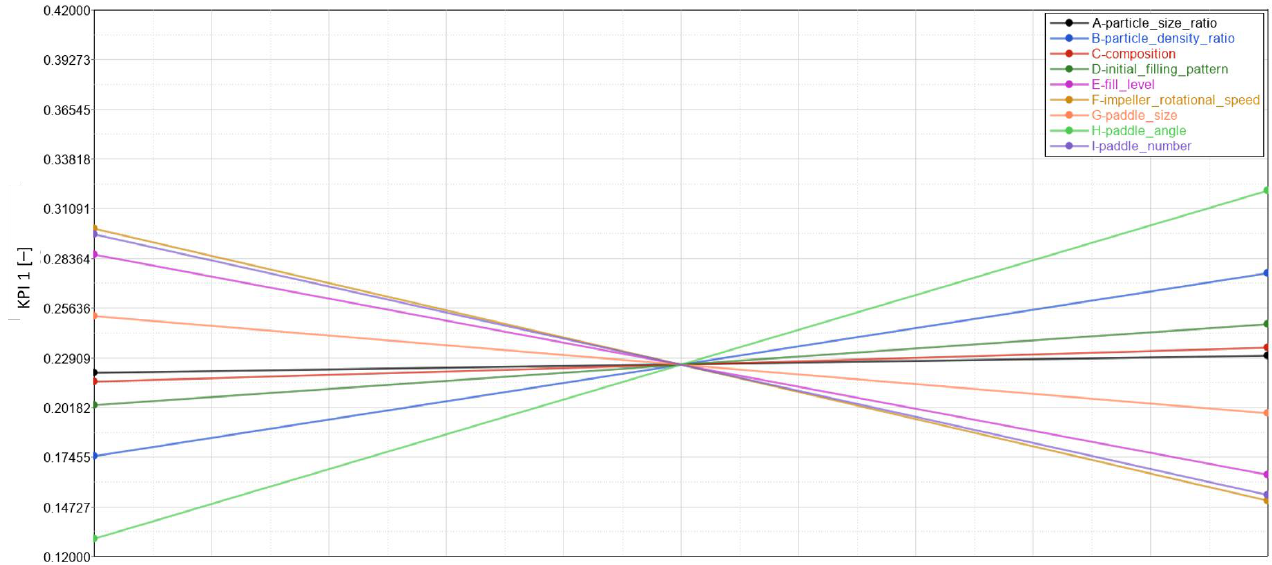
Figure 7. Main effect of factors on KPI 1 mixing quality.